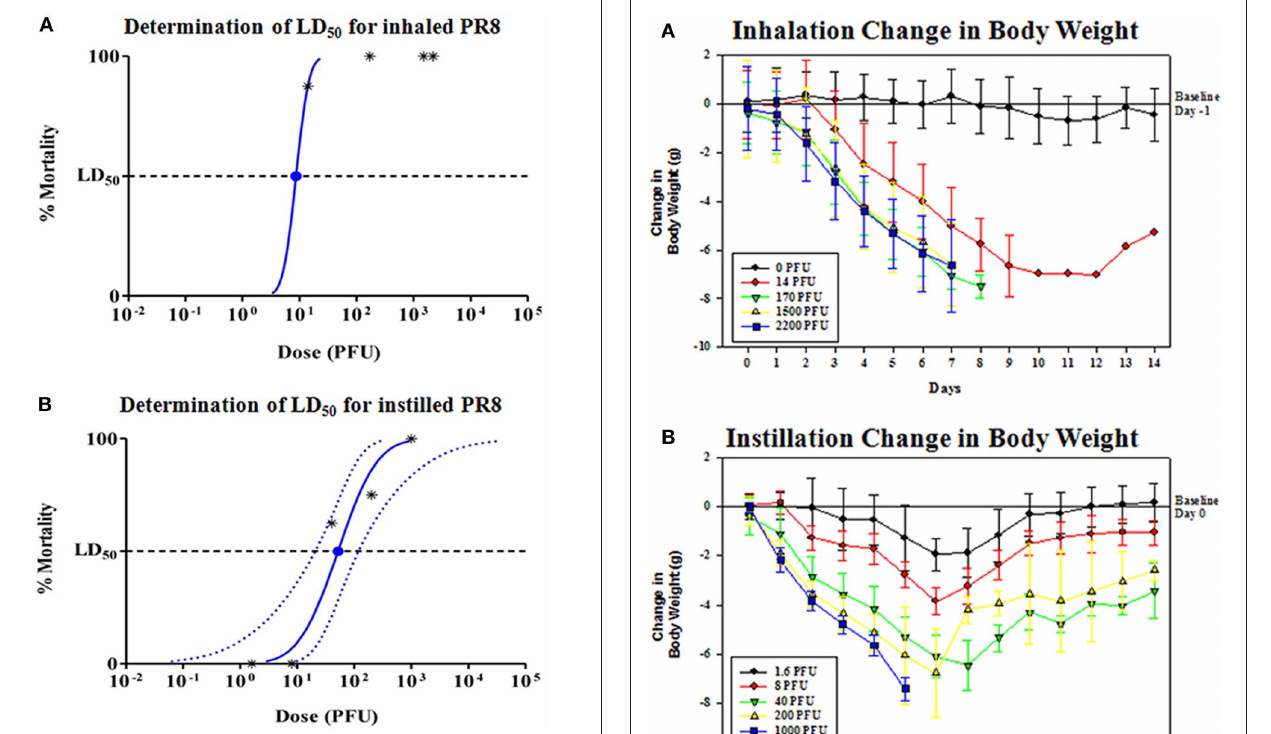
FIGURE 3 | Probit analysis to determine LD 50 for (A) inhaled, and (B) instilled PR8. Dashed lines show 95% confidence interval for the analysis. Since > 50% of mice died in the lowest aerosol challenge group, 95% confidence intervals are not shown for inhaled PR8. FIGURE 4 | Change in body weight for groups of mice challenged with